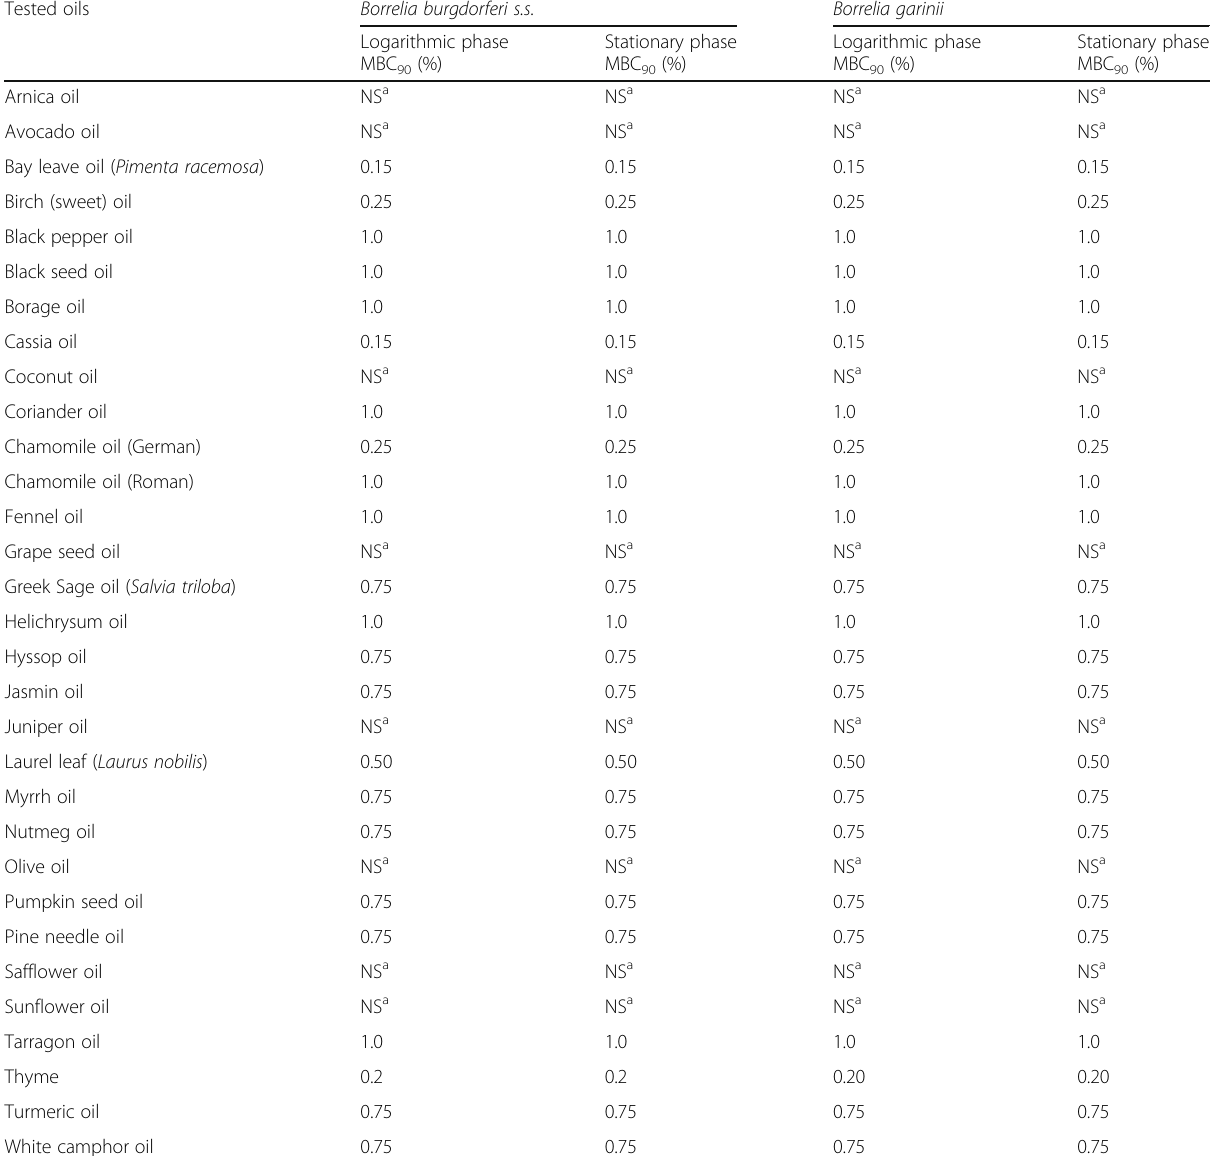
Table 1 Bactericidal efficacy of organic oils against logarithmic and stationary phases of Borrelia burgdorferii s.s. and Borrelia garinii Tested